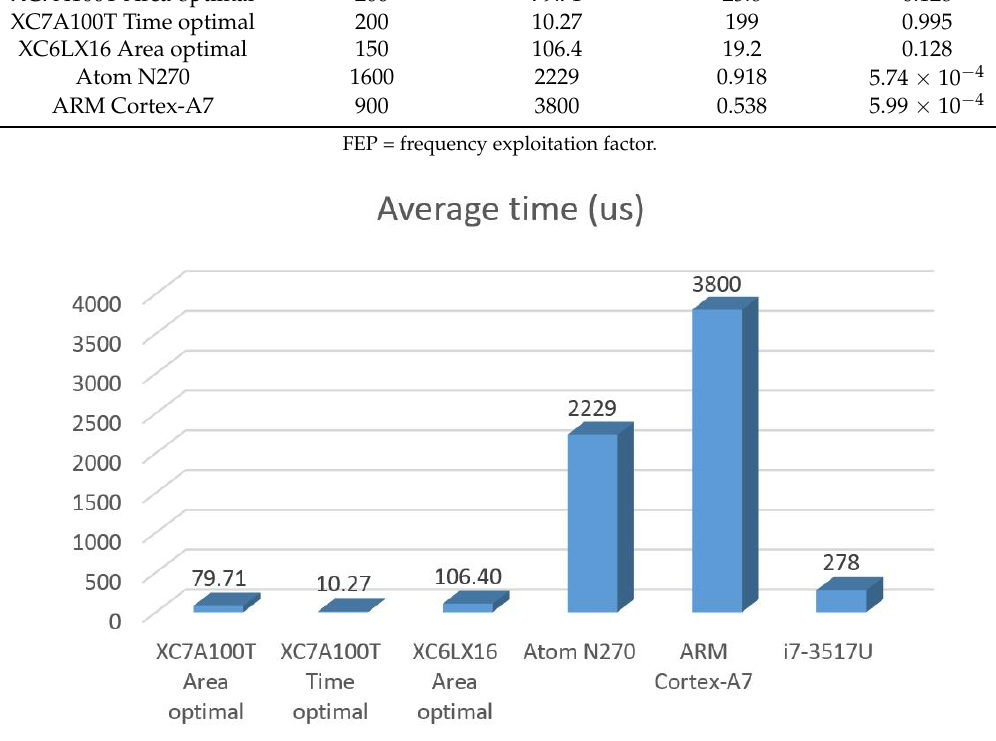
Figure 8. Average time per iteration.